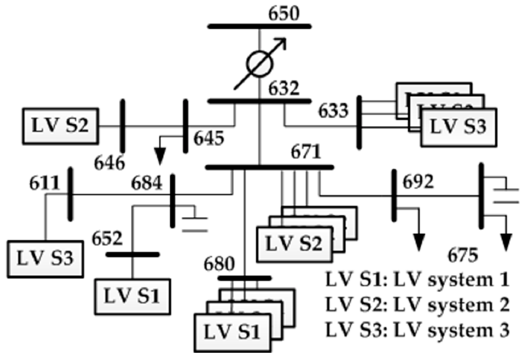
Figure 6. Modified Institute of electrical and electronics engineers (IEEE) 13-bus test feeder.